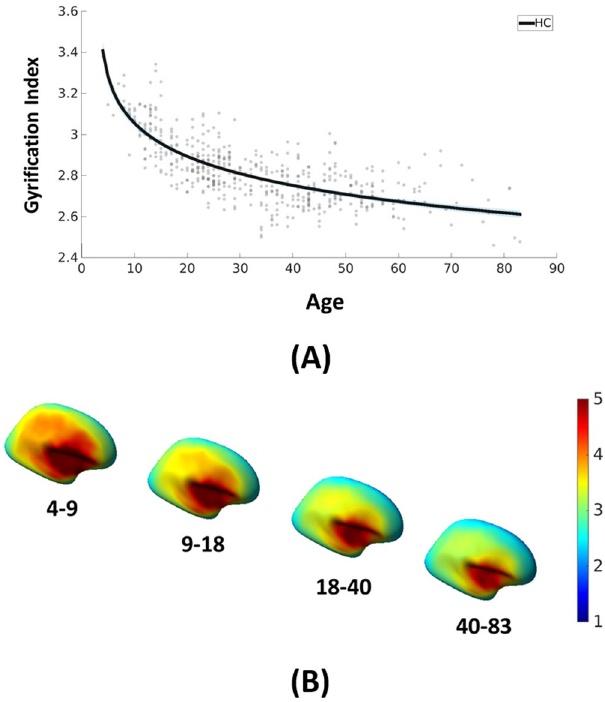
Figure 2. The gyrification index trajectory during normal development and aging. ( A ) The non-linear gyrification index trajectory for healthy subjects. The trajectory was well fitted with GI = a + b * ln(age + c) , where a = 3.4000, b = − 0.1746 and c = − 2.9991. Note that the thin light gray area along the black line indicates the 95% fitting confidence of the trajectory. ( B ) Brain gyrification changes over lifespan. Regional gyrification was high in childhood and adolescence, but the decrease rate was also high during these periods. Overall gyrification indices across the brain were low in adulthood, but the decrease rate was also low. The age ranges were chosen to best represent the gyrification changes. Only lateral view is shown, because the gyrification changes of medial regions over the lifespan was much less than the lateral regions (see Fig. S3). The colors represent the GI